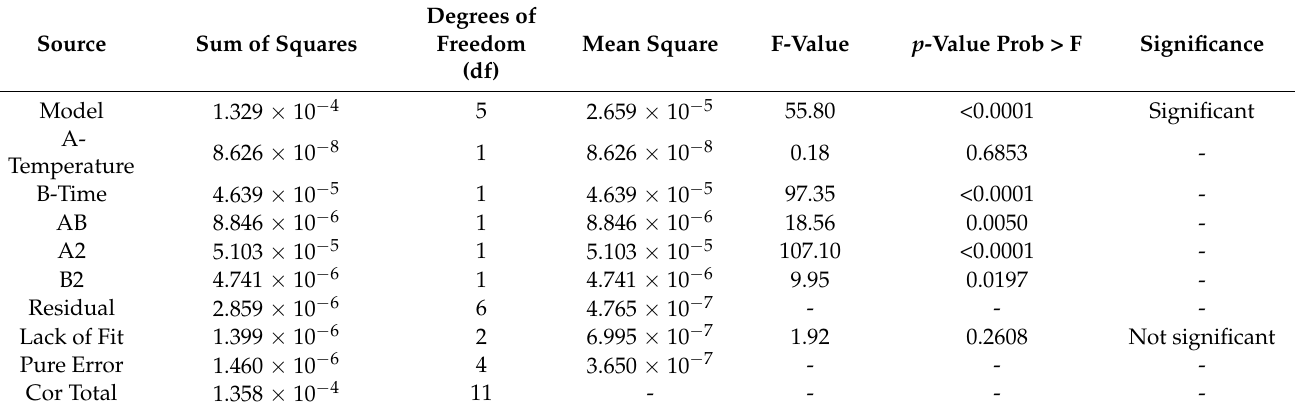
Table 4. The ANOVA table for the COF of the MoS 2 nanolubricants.